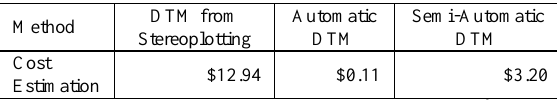
Table 6. Cost estimation in production per km